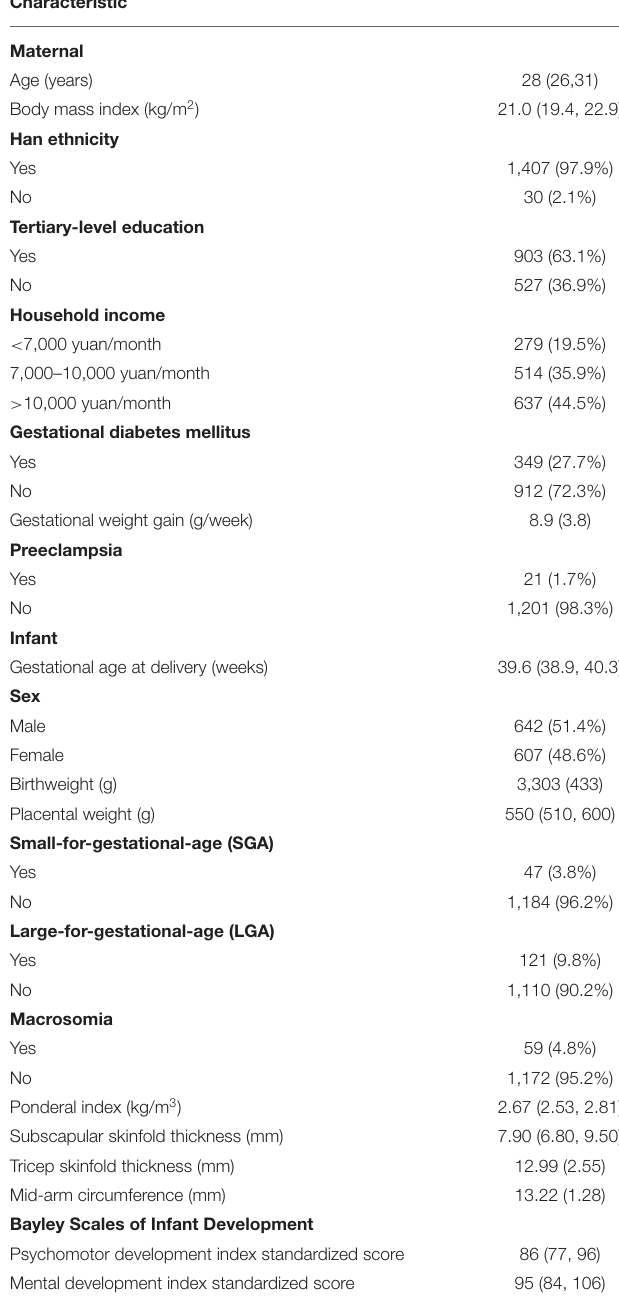
TABLE 1 | Participant (maternal and infant)